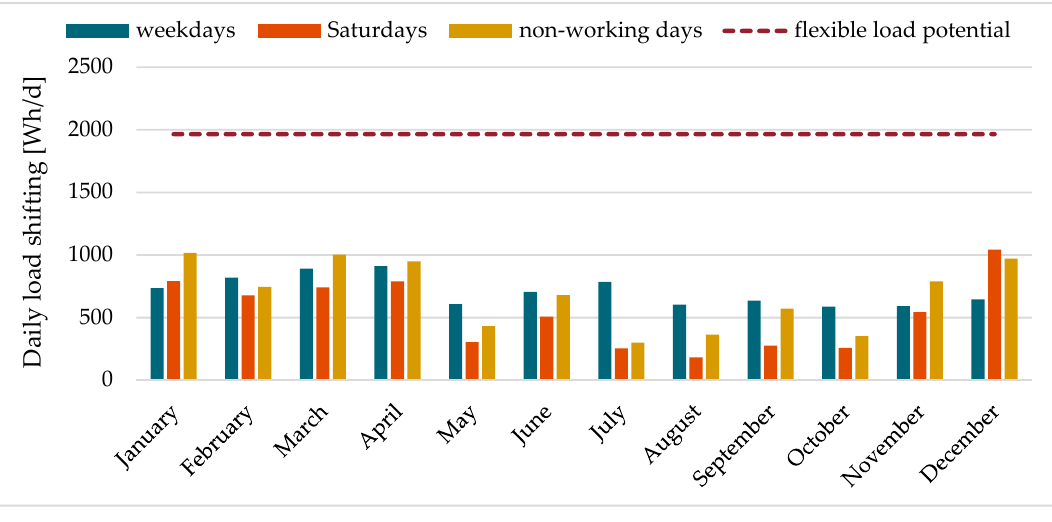
Figure 19. Daily load shifting deriving from the strategy application by month and day typologies. The dot line represents the available daily shiftable loads to participate at the flexibility mechanism.